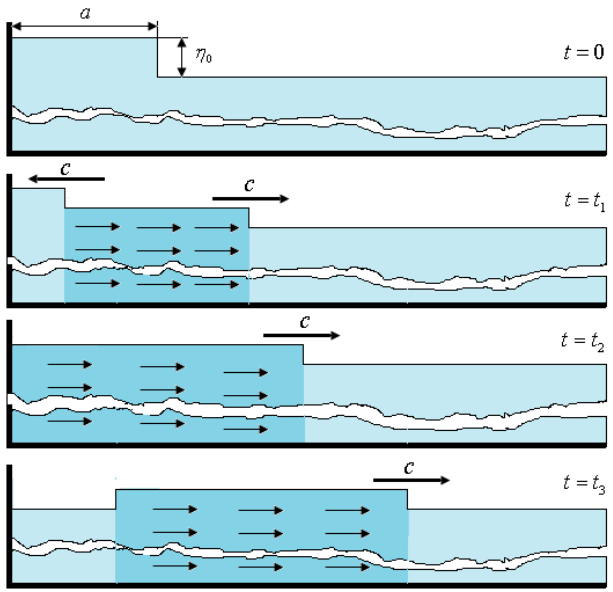
Figure A2. The process of generating a model wave by a caisson-type generator. At time t = 0, there is a given level difference in the wave generator and in the working channel, and the fluid velocity is zero everywhere. For t > 0, the given arbitrary discontinuity of levels splits into two waves. At t = t 1 , the wave A 1 = − η 0 /2 moves inside the generator, and the wave A 2 = η 0 /2 moves into the working channel. At t = t 2 , wave A 1 is reflected from the wall and, together with wave A 2 , forms a single wave of length L = 2 a , which moves into the working channel (see t = t 3 ).